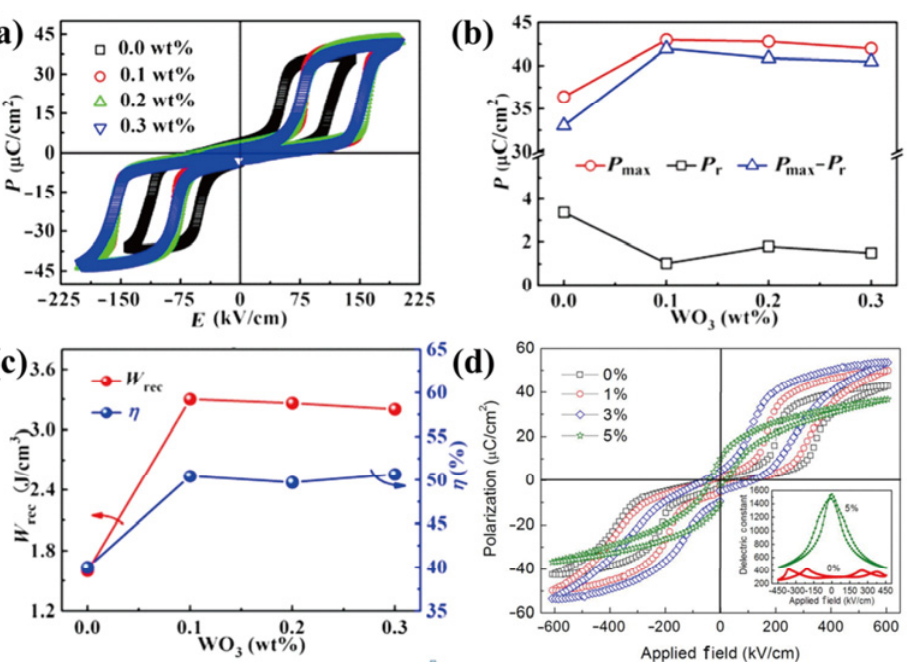
Fig. 13 (a) P – E loops, (b) P max − P r , and (c) energy storage performance of W 6+ -doped AN ceramics. (d) P – E loops of W 6+ -doped PZO films. Reproduced with permission from Ref. [142] for (a–c), © American Chemical Society 2017; Ref. [143] for (d), © AIP Publishing LLC